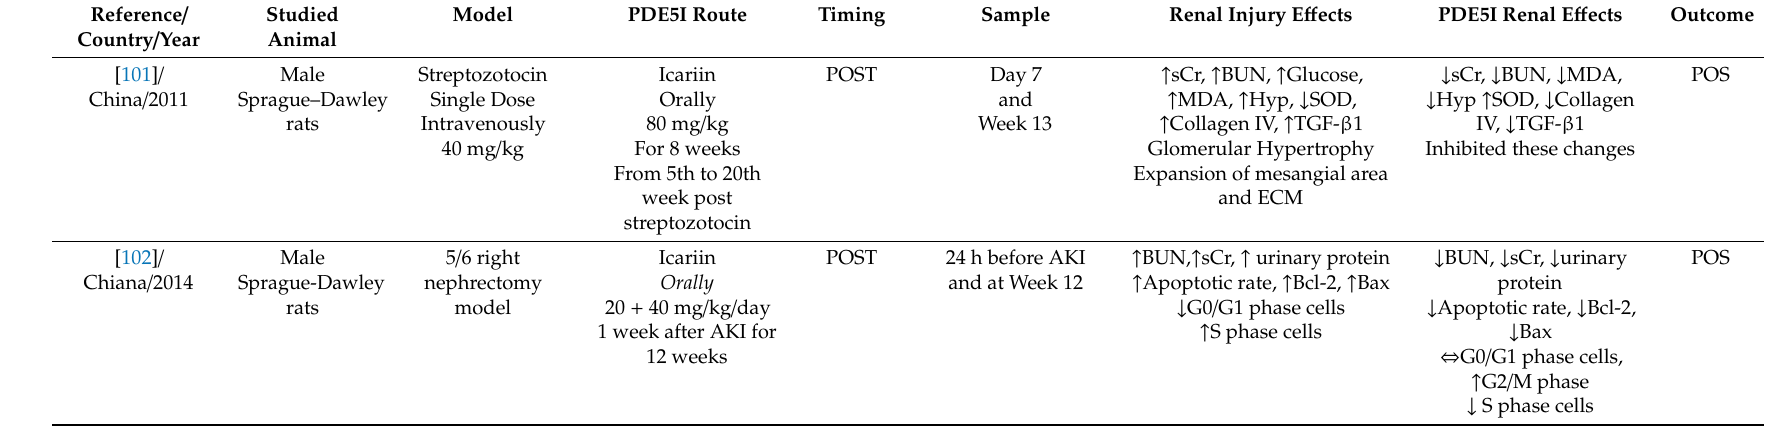
Table A3. Animal studies evaluating the potential reno-protective e ff ects of